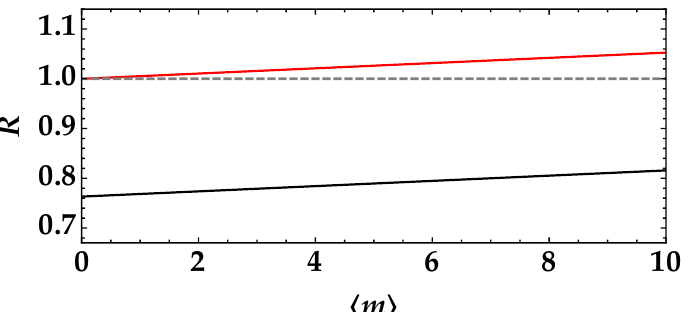
Figure 1. R as a function of the mean number of photons for t = 0.9, µ = 1, and η = 0.25 in the case of a multi-mode twin-beam state (black curve) and a multi-mode pseudothermal state (red curve). The gray dashed line at R = 1 defines the boundary condition between classical and quantum